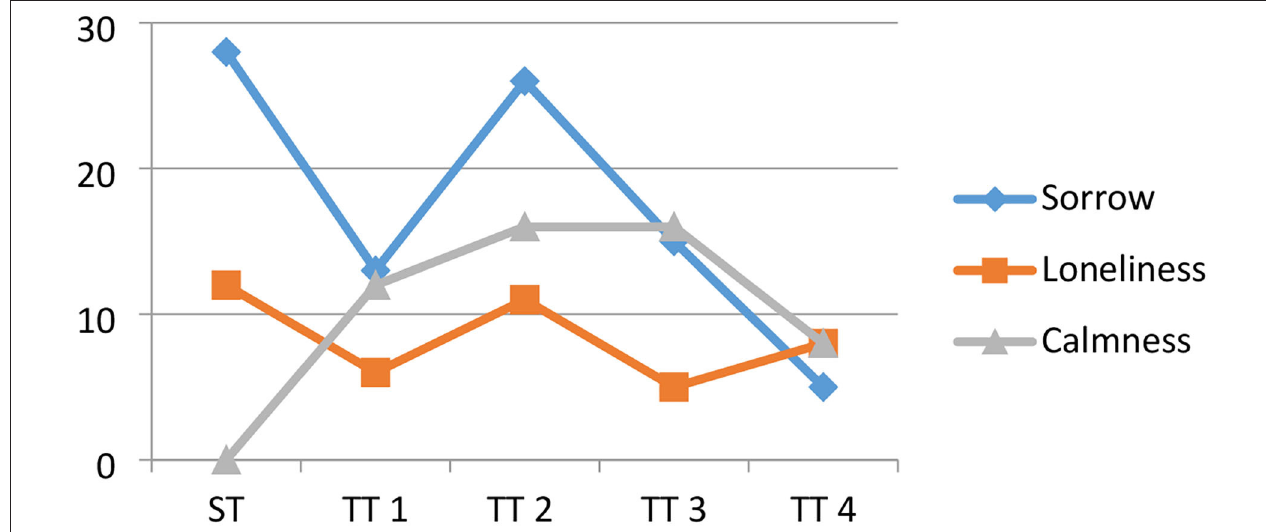
FIGURE 3 | The number of the main emotions in different versions of the